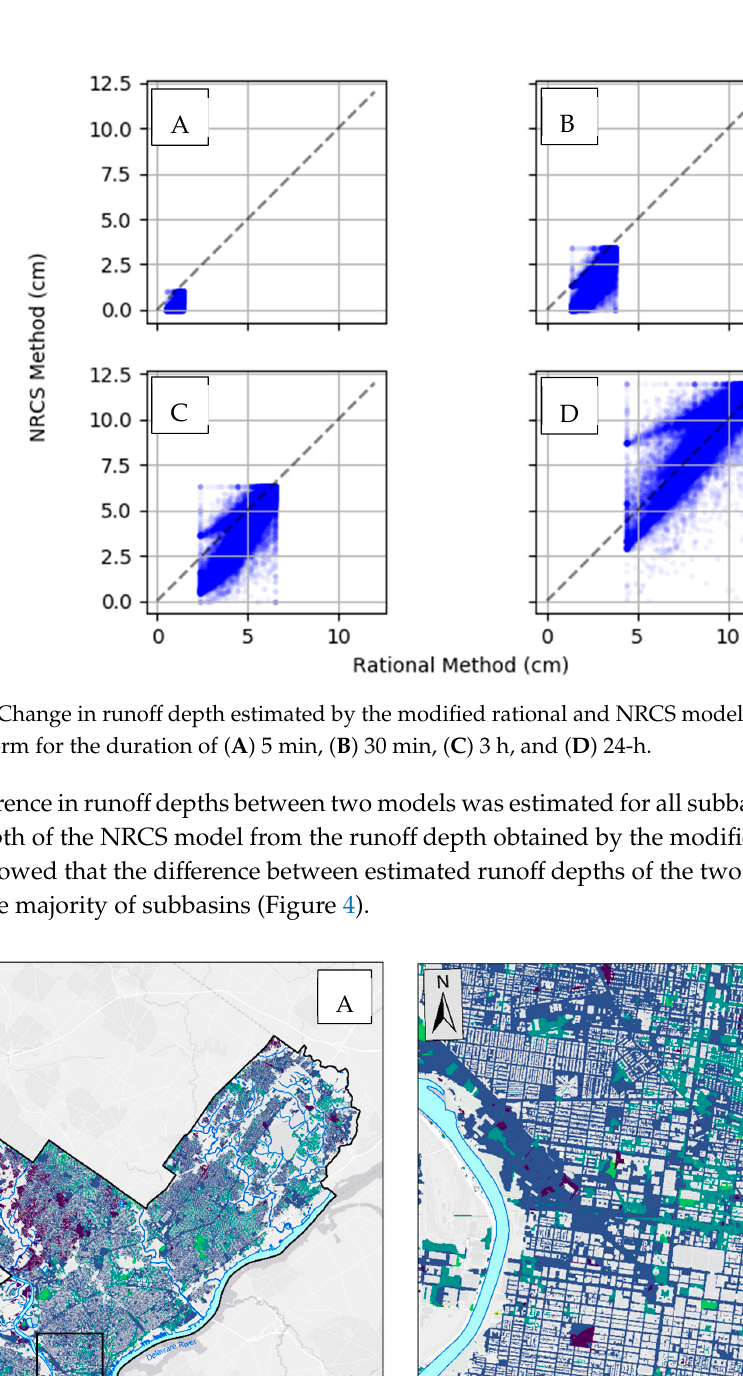
Figure 4. The di ff erence in runo ff depth between runo ff depths estimated by the modified rational and Figure 4. The difference in runoff depth between runoff depths estimated by the modified rational NRCS methods for all subbasins in ( A ) city of Philadelphia and ( B ) Center and NRCS methods for all subbasins in ( A ) city of Philadelphia and ( B ) Center City.